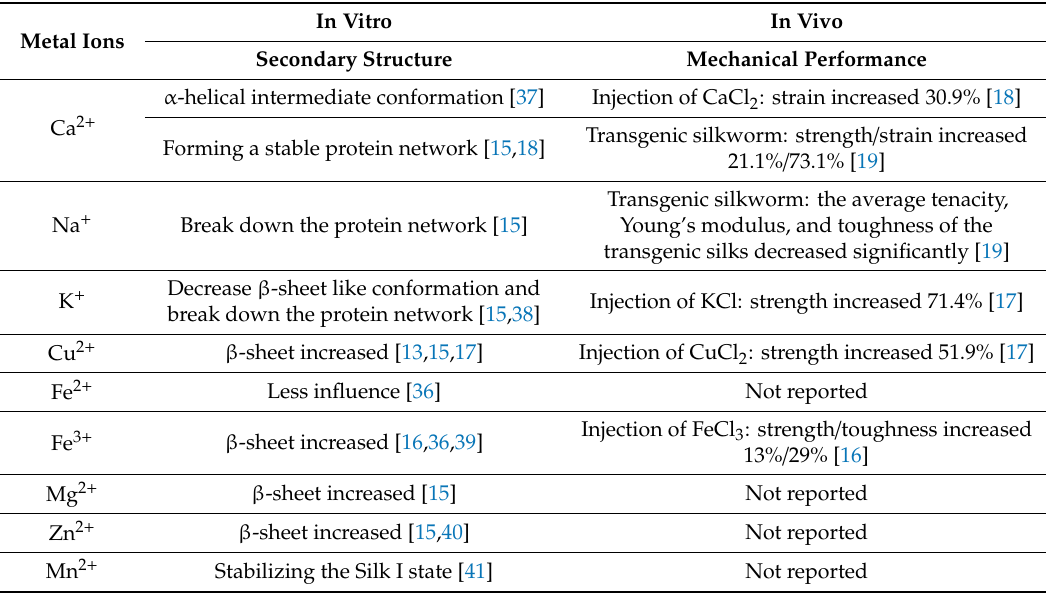
Table 2. Current research on the e ff ect of metal ions on silk structure and performance in vitro and in